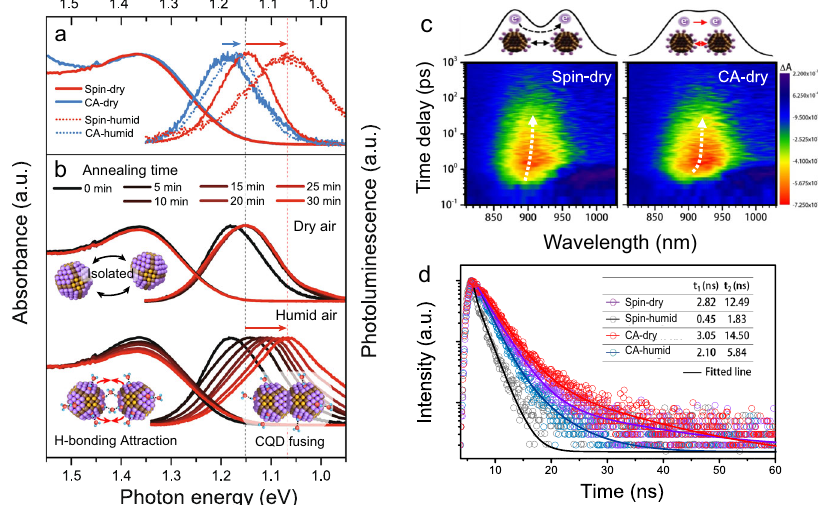
Fig. 3 Spectroscopy and carrier dynamic studies of the CQD solids impacted by ambient water. a The absorbance, steady-state photoluminescence (PL) spectra of PbS-I CQD fi lms prepared by spin coating and CA under different humidity. b The change of absorbance and PL spectra of spin-coated PbS-I CQD fi lms versus heating time under dry and humid air. c Pseudo-color TA spectra of PbS-I CQD fi lms by spin coating and CA. The color scales for a spin and CA fi lms are the same and proportional to the absorption change in each graph. All samples were pumped by 470 nm laser pulse with the pump fl ux of 25 J·cm − 2 . d Transient PL decay of CQD fi lms; inset table: the fast and slow time component fi tted by double-exponential